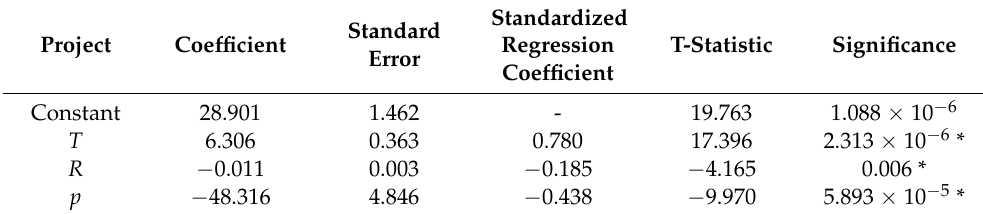
Table 5. Regression parameters of multiple linear